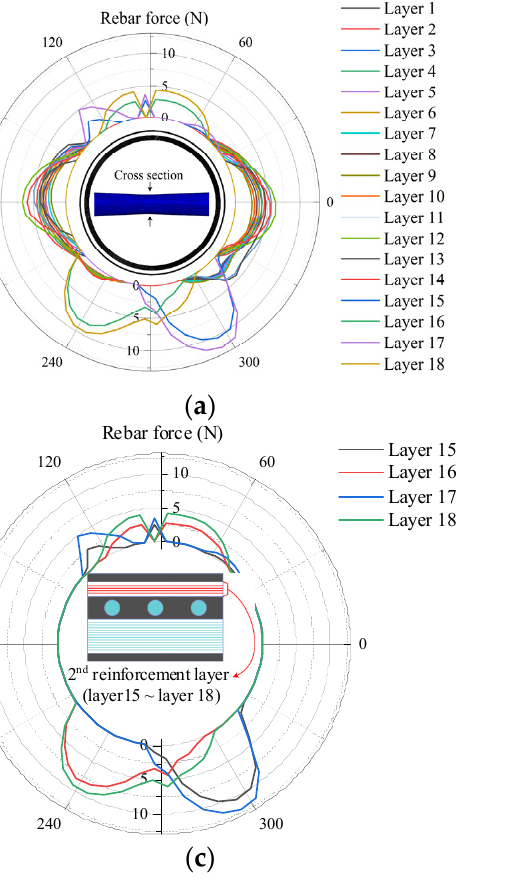
Figure 8. Rebar force of the cord with non-collapse: ( a ) full cords, ( b ) inner cords, ( c ) outer cords, ( d ) maximum of the force in each cord.